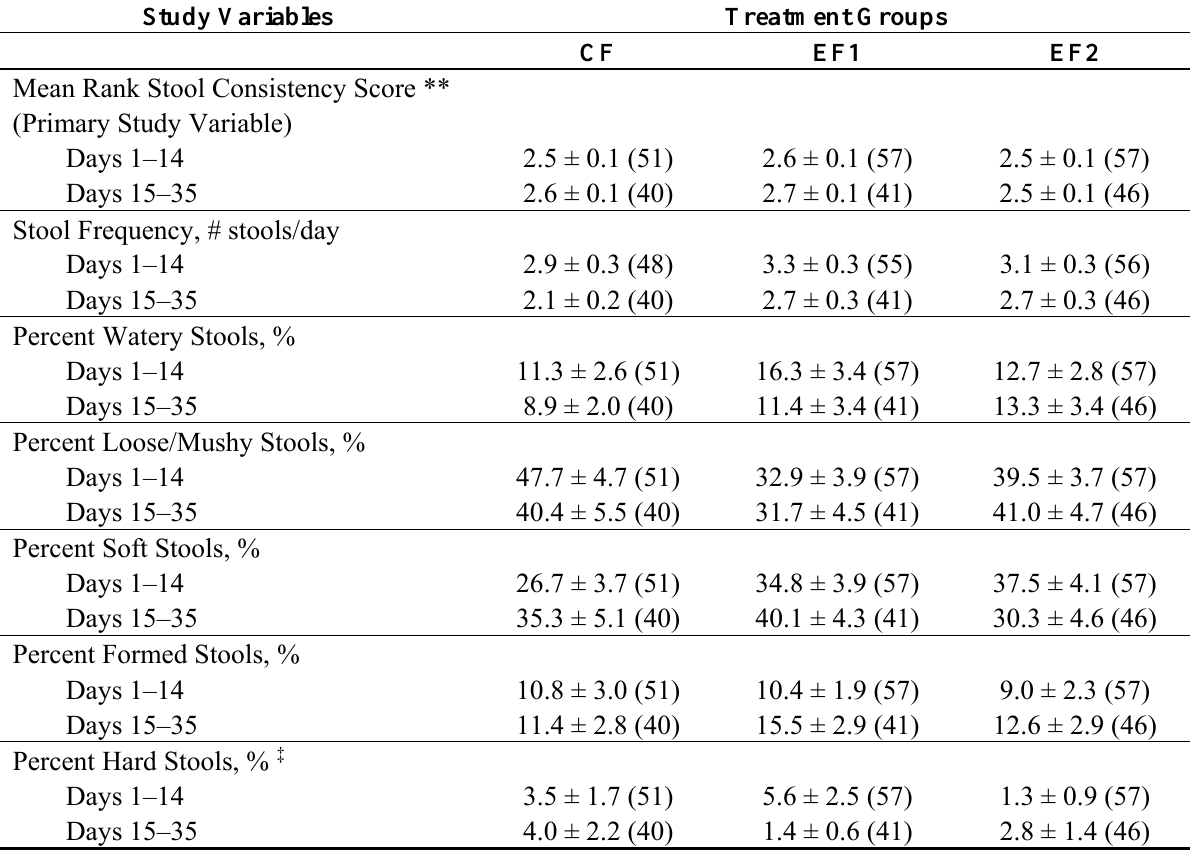
Table 4. Stool characteristics in study evaluable (EV) subjects *.